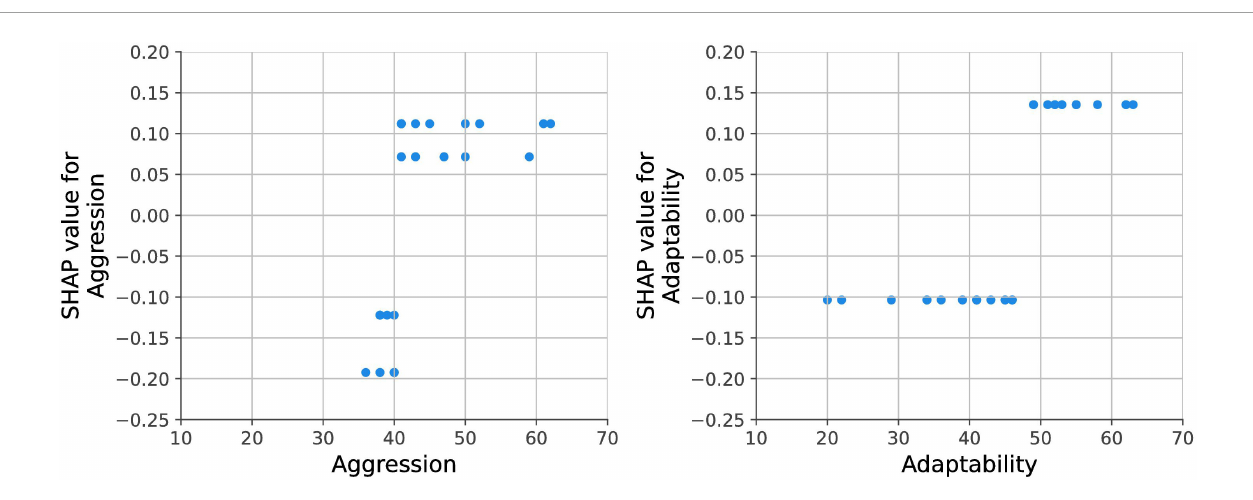
FIGURE6 Aggression and adaptability dependence